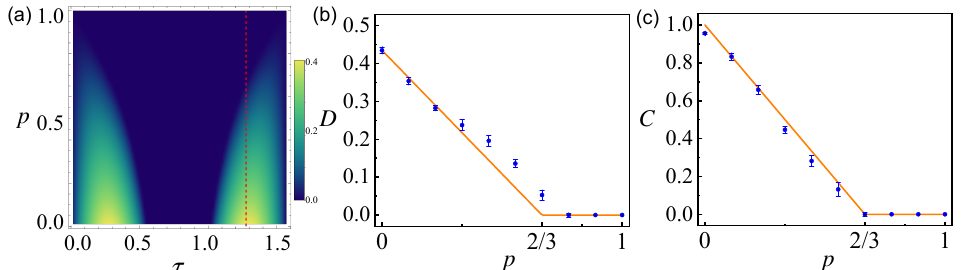
Figure 3. Performance of the protocol for mixed entangled states. ( a ) Numerical analysis of D dependence of p and τ . The density is colored according to the degree of the distance D . The dashed π . ( b ) Results of performing the protocol for detecting initial entanglement. τ red line indicates τ = 13 32 π such that ρ SE is always detected as entangled as long as p < 2 is fixed to 13 32 in good agreement with that of directly detecting ρ SE via 2-qubit QST, as shown in ( c ). ( c ) Concurrence of the initial states ρ SE for different state parameters p , obtained via 2-qubit